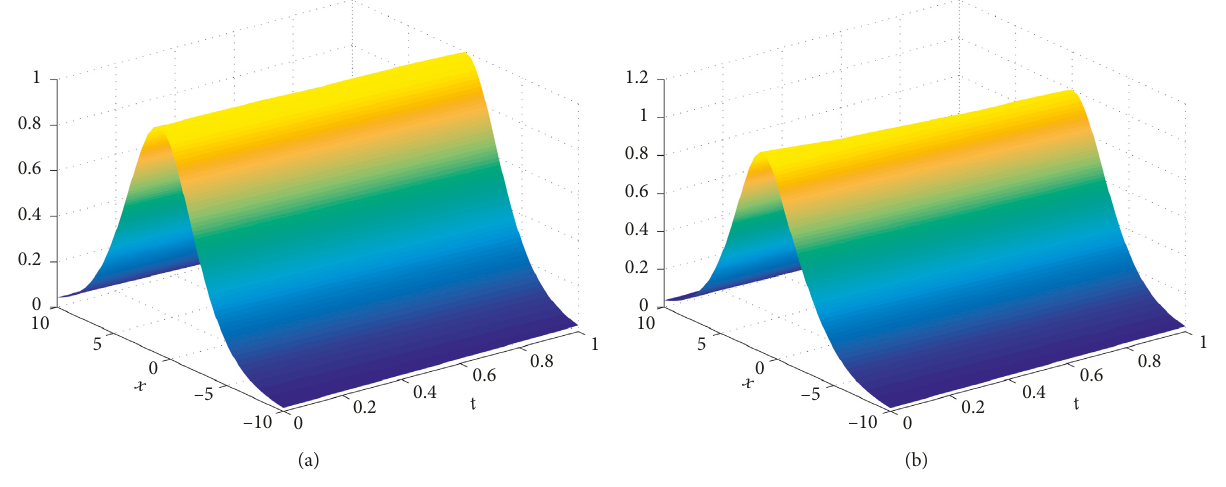
Figure 3: 3D graphics of exact and approximate solutions. (a) 􏽥 u ( x, t )